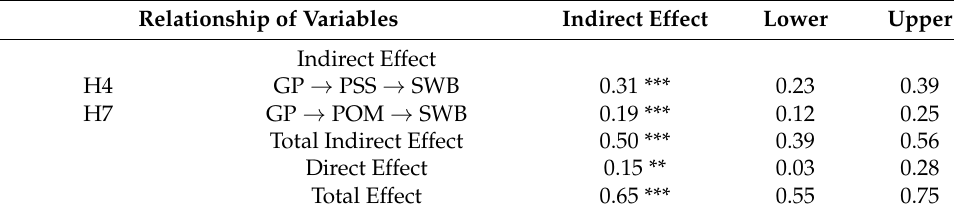
Table 5. Results of indirect effect analysis of Model